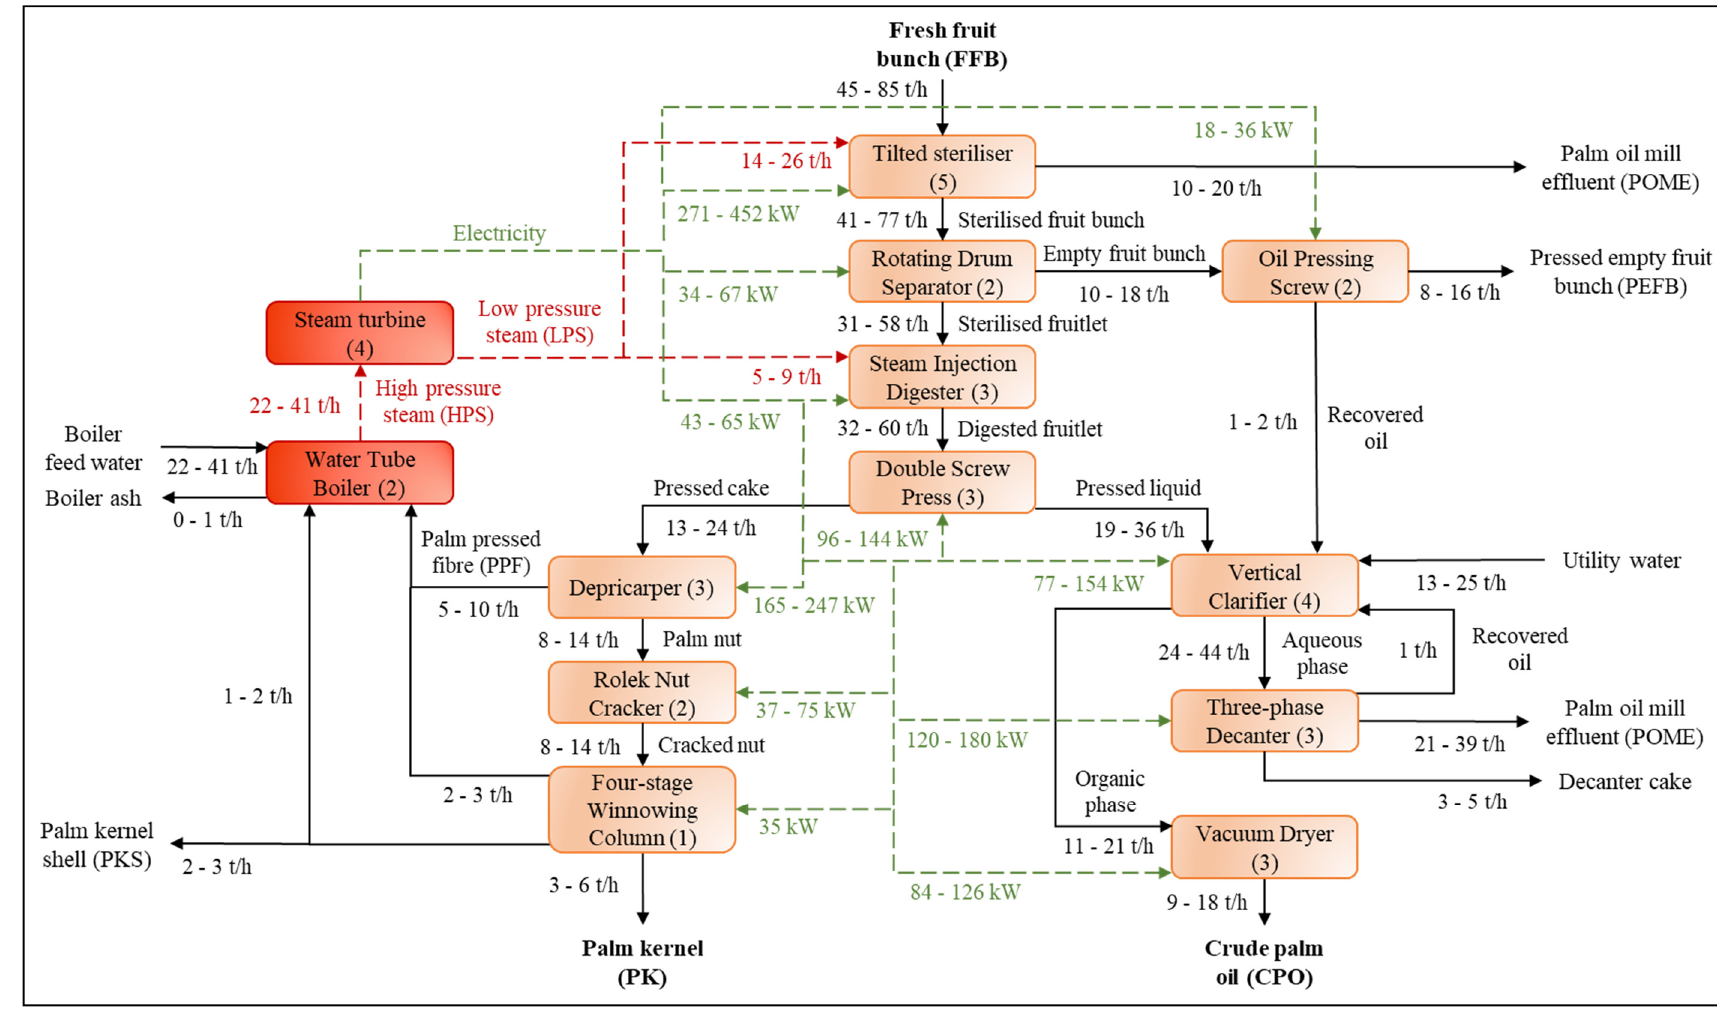
Figure 3. Baseline POM design.